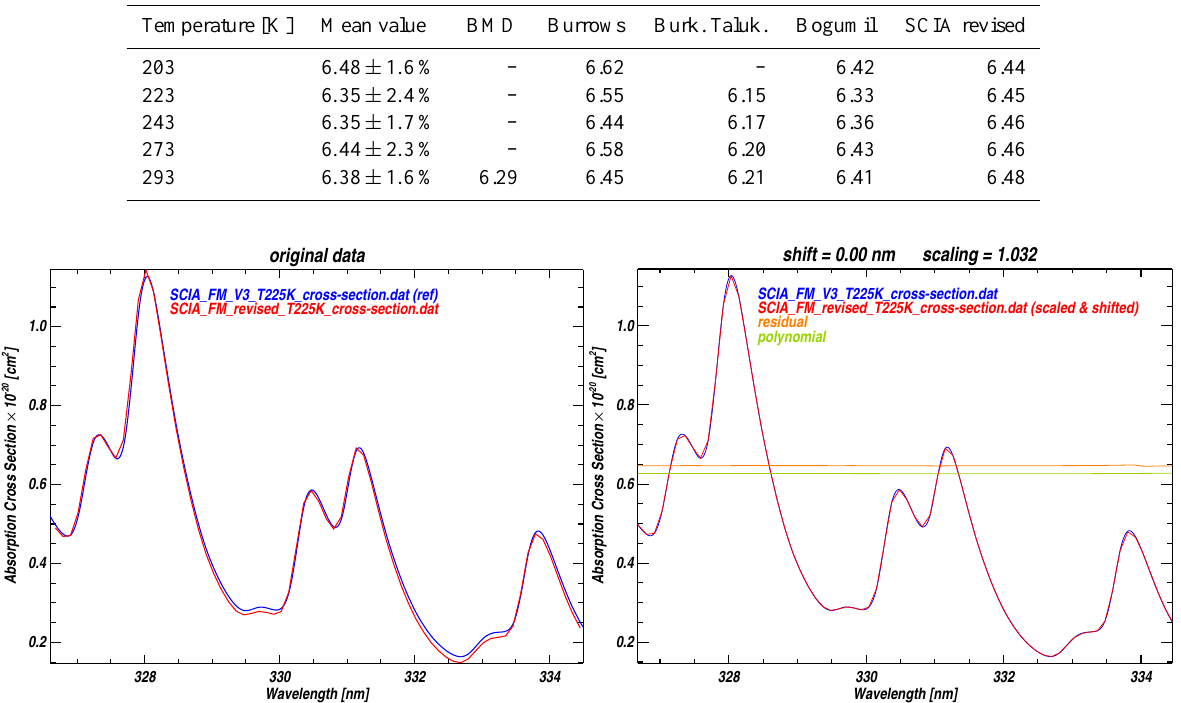
Fig. 10. (Left) Comparison of SCIAMACHY FM revised data with Bogumil et al. (2003) data (reference) at 225K in the DOAS fitting window (326.6–334.5nm). (Right) The fitted revised SCIAMACHY FM data (scaled and shifted) and Bogumil et al. (2003) data together with the residuals (orange) and the retrieved baseline polynomial (green), the latter two shifted vertically for